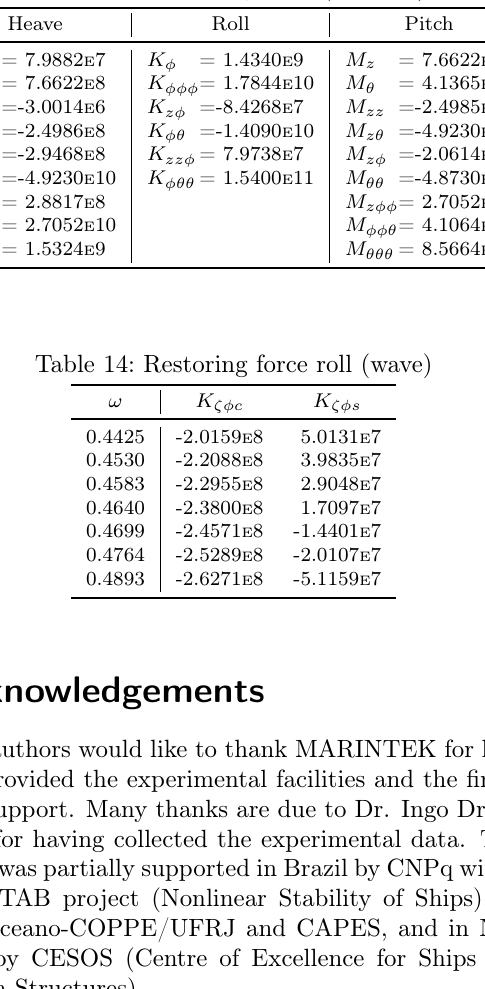
Table 12: Restoring force (motions)